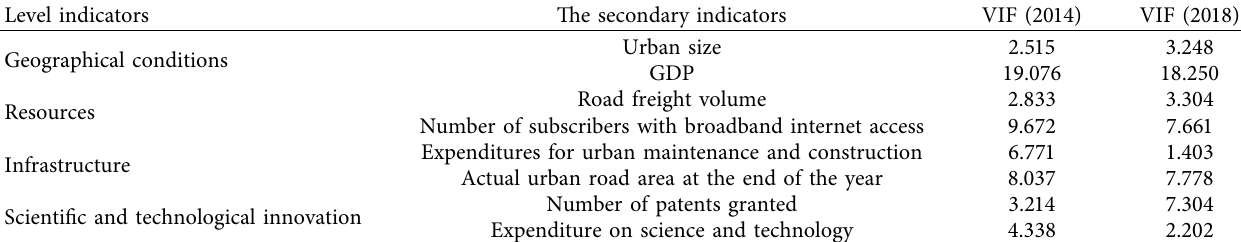
Table 2: Collinearity checklist.